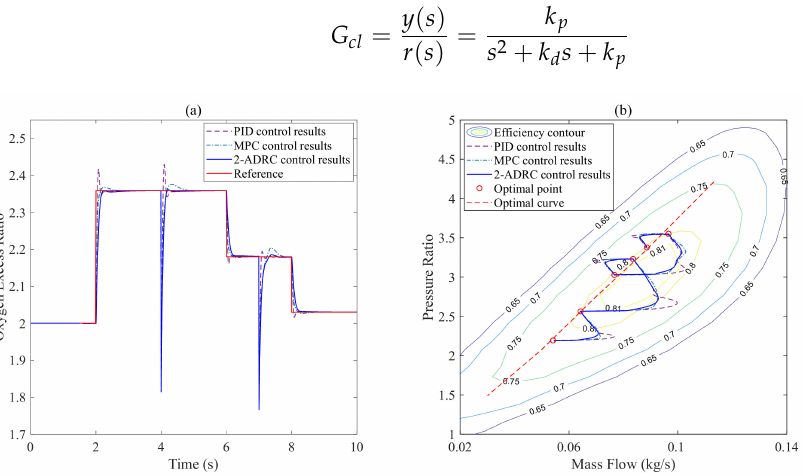
Figure 8. 2-ADRC algorithm simulation results: ( a ) Oxygen excess ratio following curve; ( b ) Com- pressor mass flow and pressure ratio